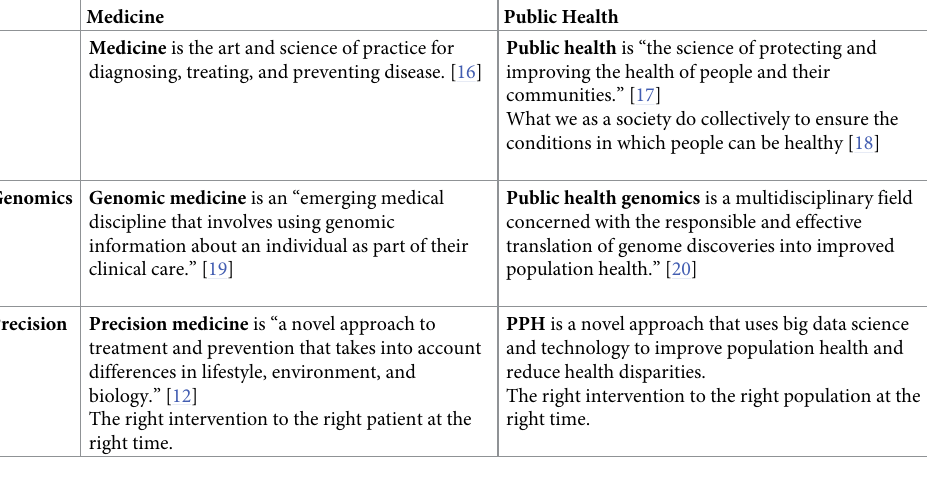
Table 1. Genomics, precision medicine, and PPH: Definitions and